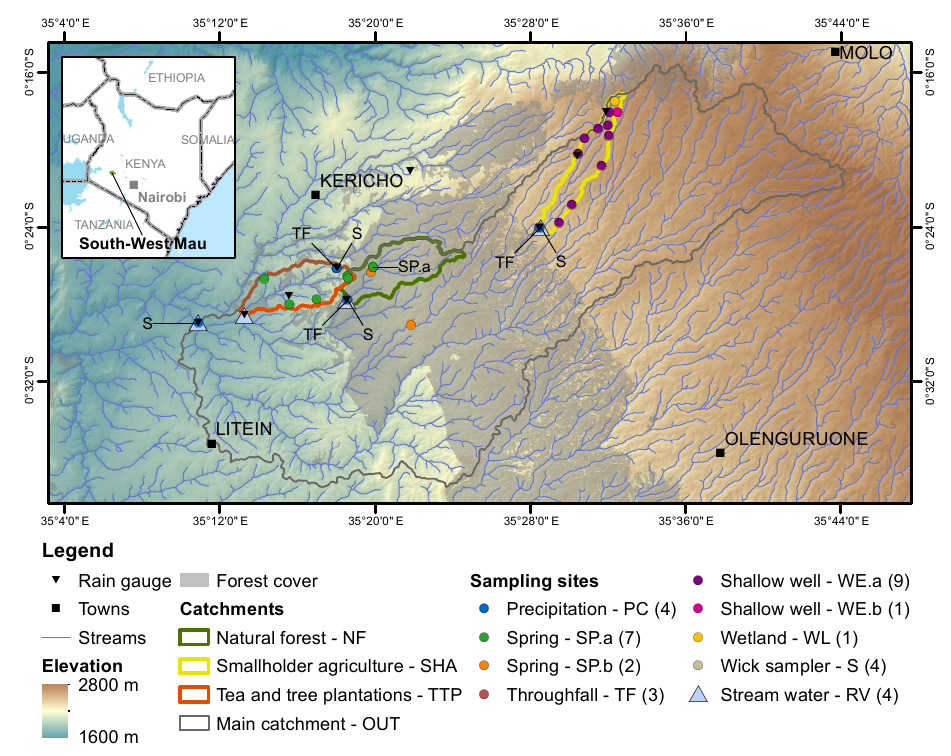
Figure 1. Map of the study area in the South-West Mau, Kenya, showing the three sub-catchments with different land use types within the main catchment, location of rain gauges, and sampling sites for stream water and selected endmembers. Sampling sites with overlapping symbols are indicated with labels instead of symbols. Numbers in brackets in the legend indicate the number of sampling sites per endmember.